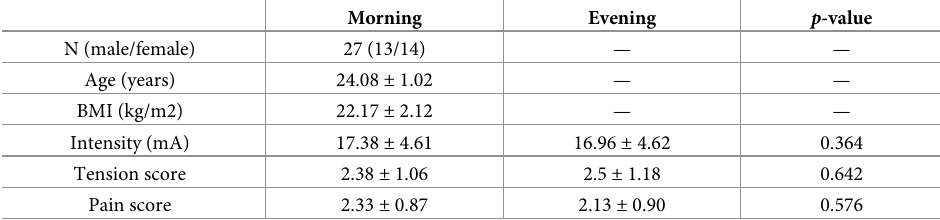
Table 1. Characteristics and scale scores of